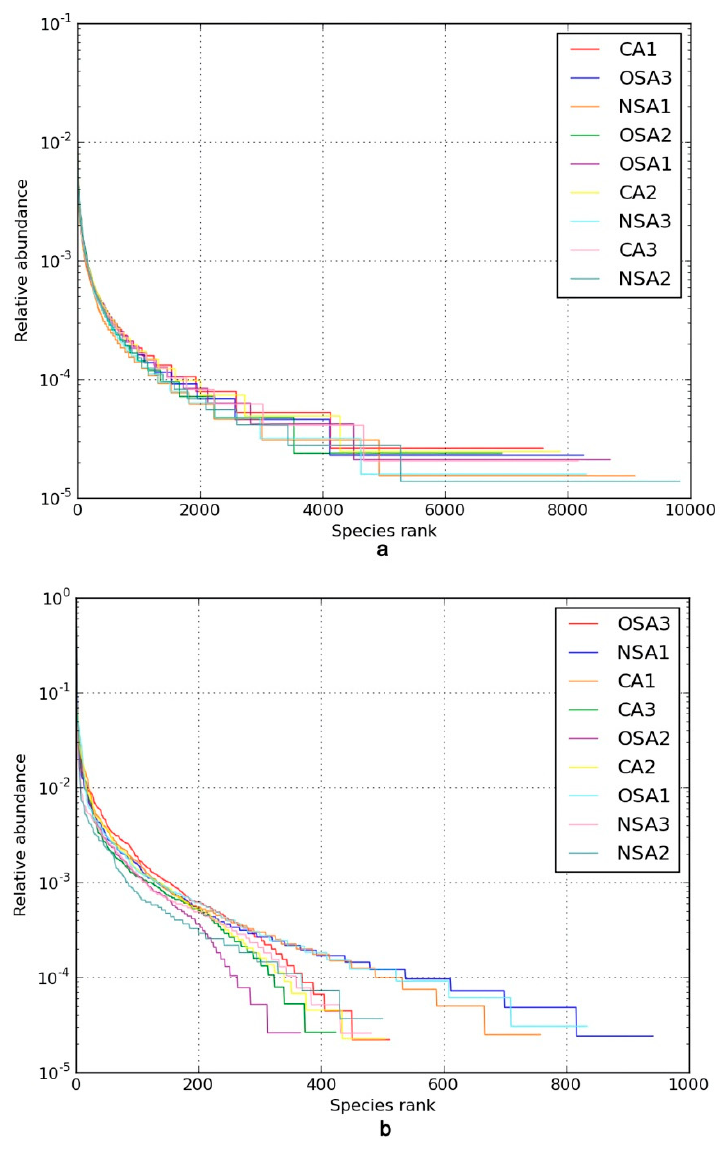
Figure 3. Rank–abundance distribution curves. Note: ( a ) Rank–abundance distribution curves of bacteria, ( b ) Rank–abundance distribution curves of fungi. Table 3. Alpha diversity indices of bacteria and fungi in soils at different depths and different sample plots.